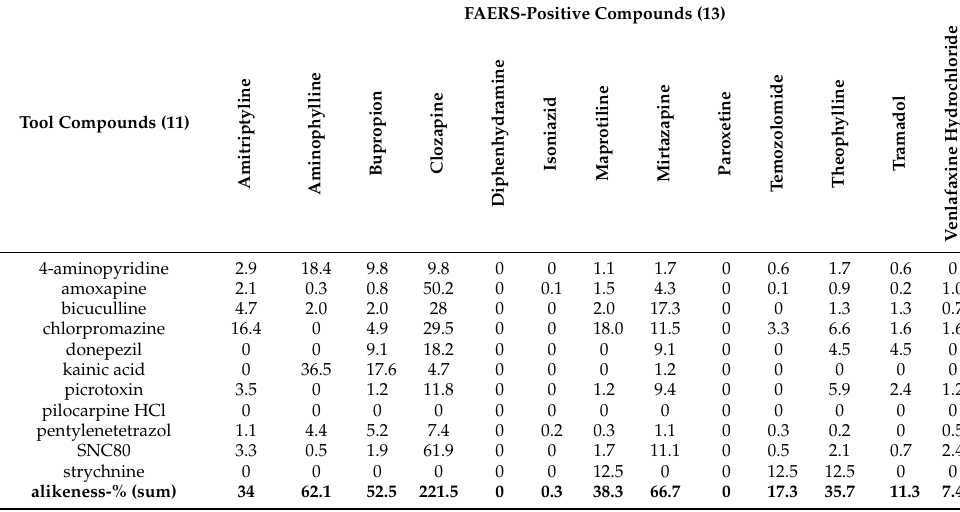
Table 5. Alikeness-% between the tool and FAERS-positive compounds.